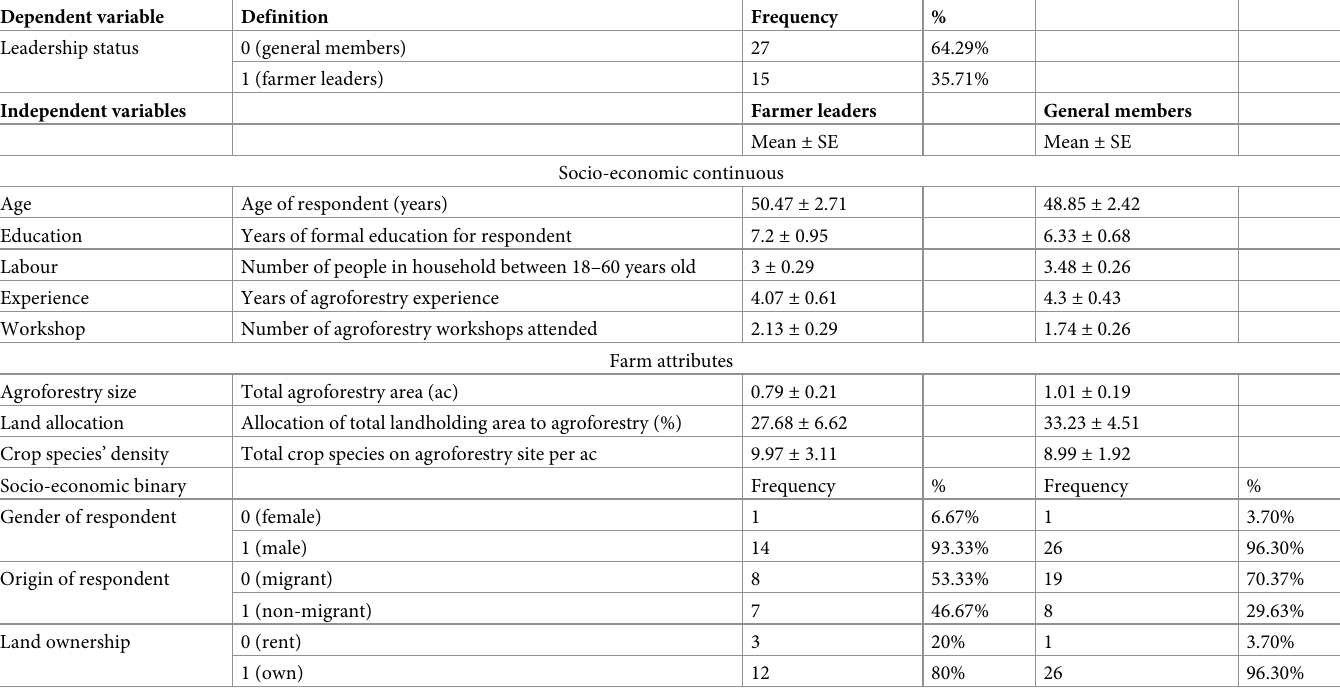
Table 2. Socio-economic variable definitions and descriptive statistics.